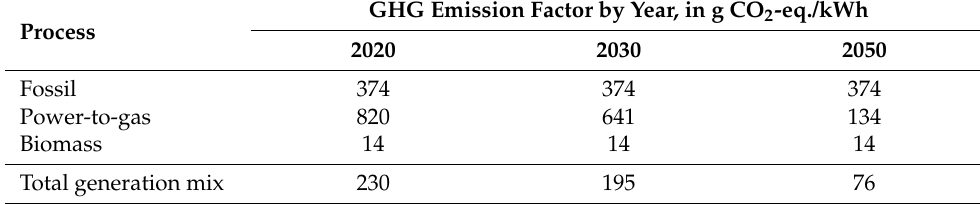
Table 12. GHG emission factors of CNG by process [10,20,63,64].